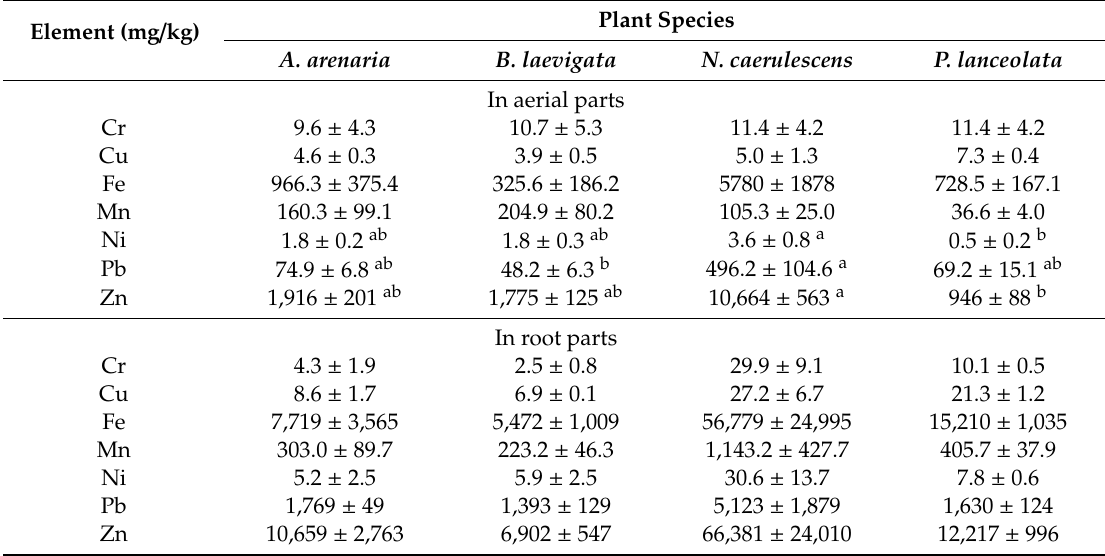
Table 3. Aerial and root part metal content (mg / kg dry weight) at La Gardie mine site. Element (mg /